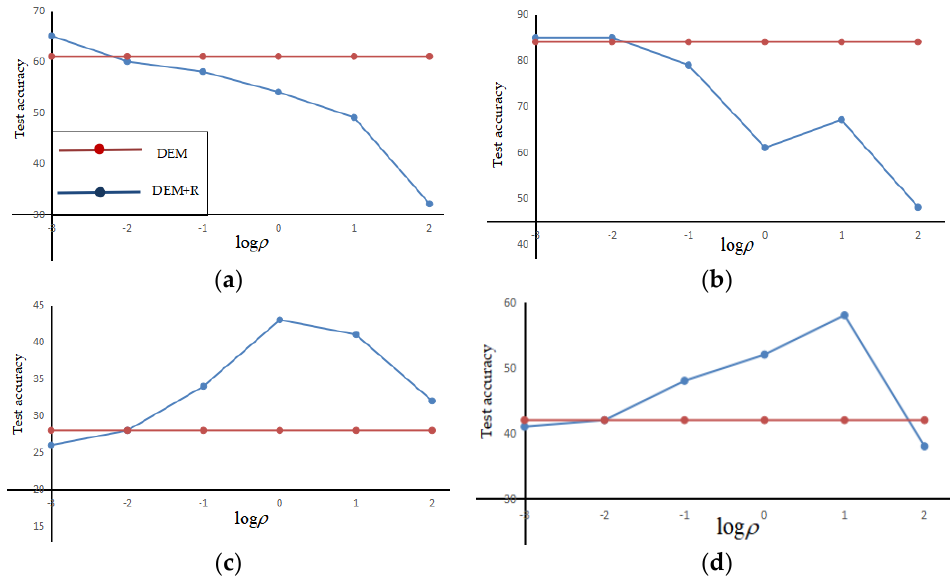
Figure 6. The accuracy change with ρ on the WHD-9, baseline model (DEM) is represented in red, TU classes precision ( a ), GS classes precision ( b ), GU classes precision ( c ), and H precision ( d ) shows in blue. Table 4. Hubness reduction using structure matching